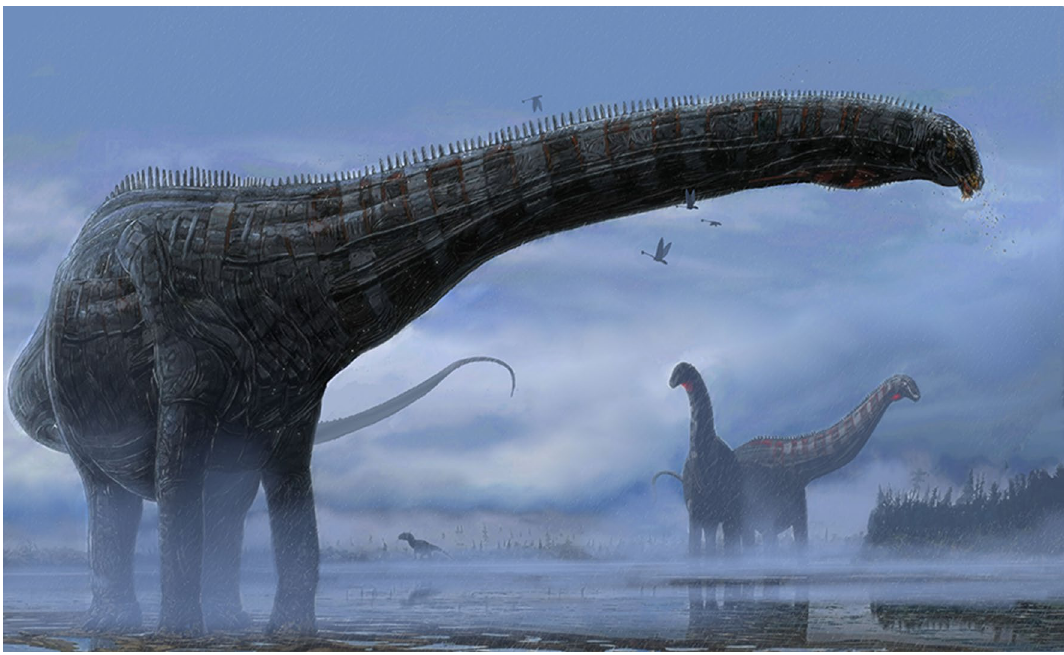
Figure 4. Hypothetical life restoration of MOR 7029. Note that the pulmonary disease infecting this animal would not been externally evident, but the probable pneumonia-like outward symptoms would have included coughing, labored breathing, nasal discharge, fever, and weight loss among others. Artwork by and copyright of Corbin Rainbolt. Image may not be used for any commercial